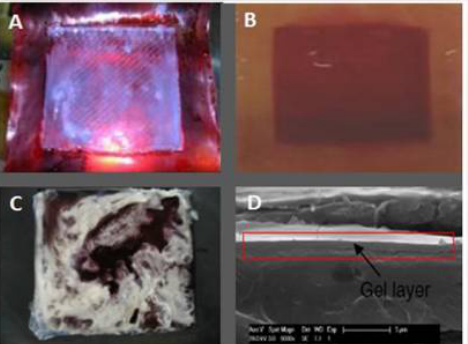
Figure 33. Examples of organic fouling (adapted with permissions). ( A ) chitosan fouling [150]; ( B ) anthocyanin fouling [151]; ( C ) protein fouling [152]; ( D ) polyacrylamide fouling [153].